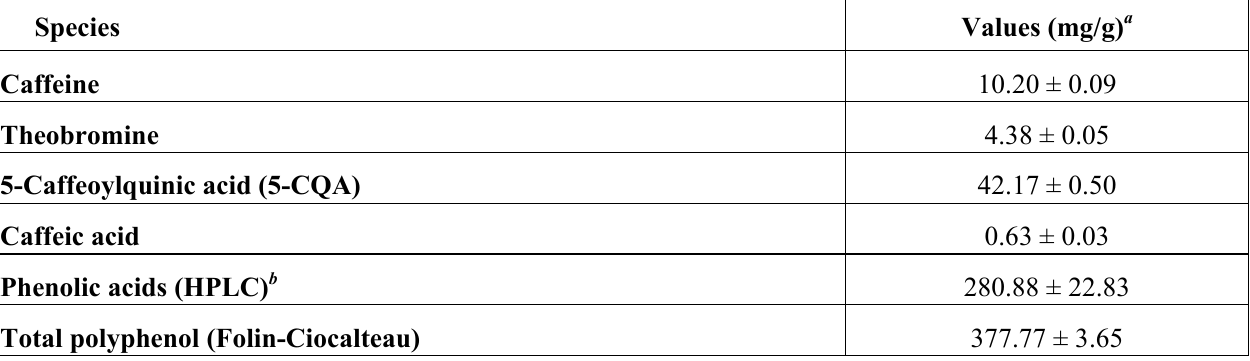
Table 1. Phytochemicals from maté tea (mg/g).